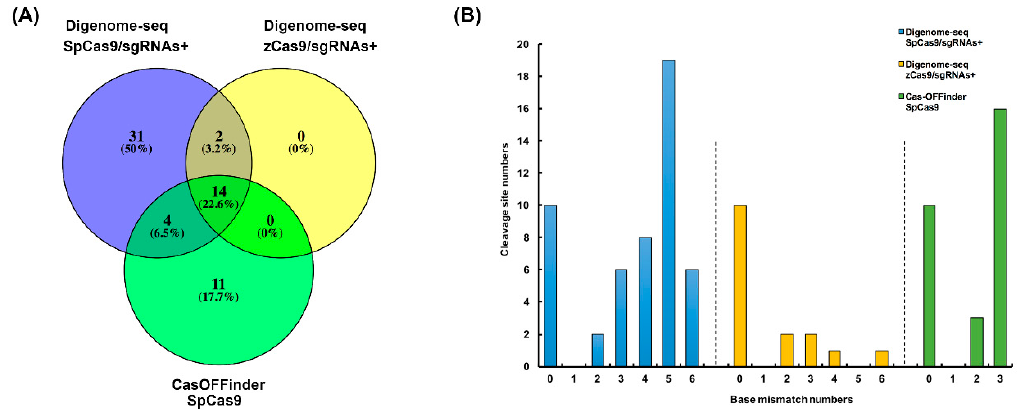
Figure 2. Comparison of off-target prediction results. ( A ) Venn diagram of predicted off-target sites of Digenome-seq and Cas-OFFinder. ( B ) Distribution of base mismatches with on-target sequences of digenome-seq and Cas-OFFinder. The number of mismatches did not include mismatches in the PAM sequence. Table 1. Number of off-target sites predicted by Digenome-seq and Cas-OFFinder. Nucleotide Mismatch